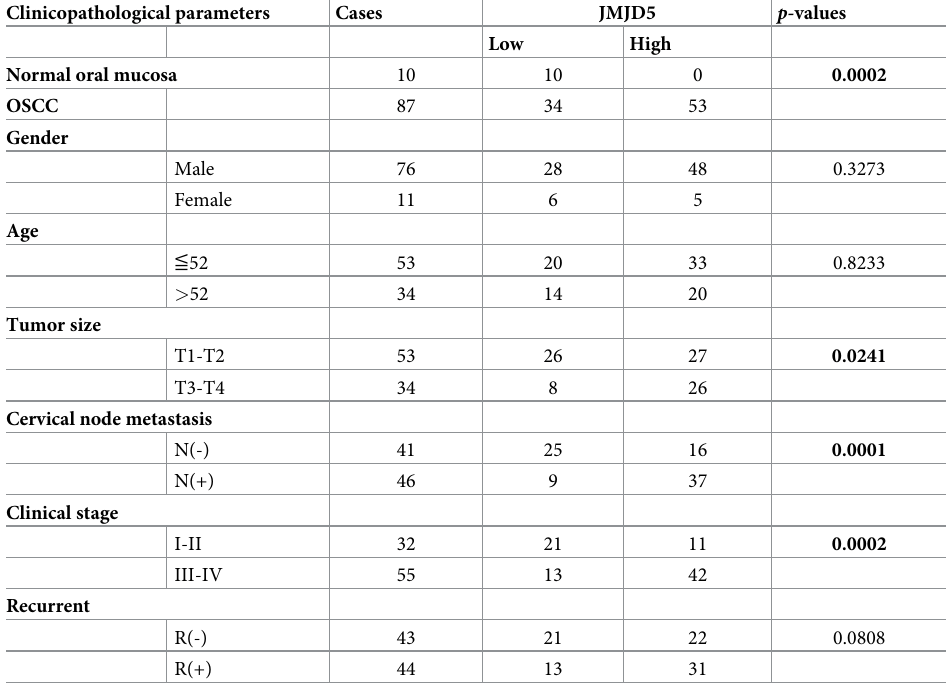
Bold font indicates significance ( P < 0.05).